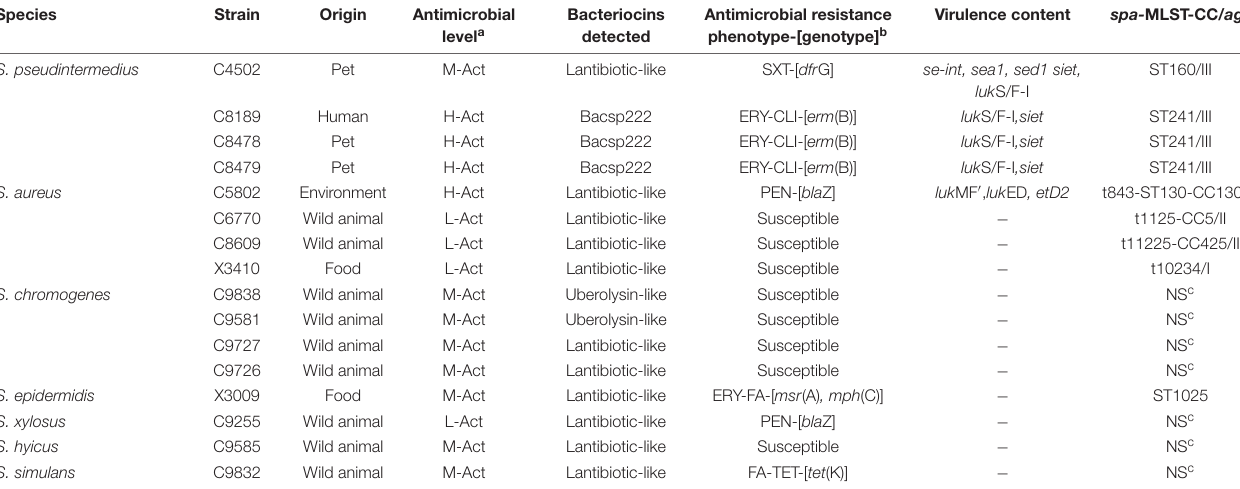
TABLE 5 | Characteristics of the BLIS + isolates that carry bacteriocin encoding genes.